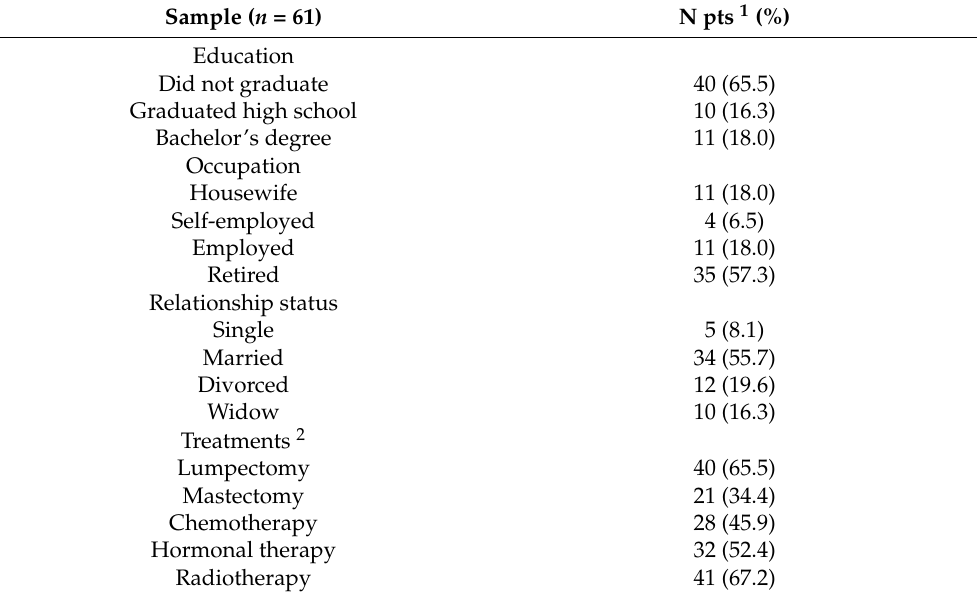
Table 1. Demographic and clinical data of